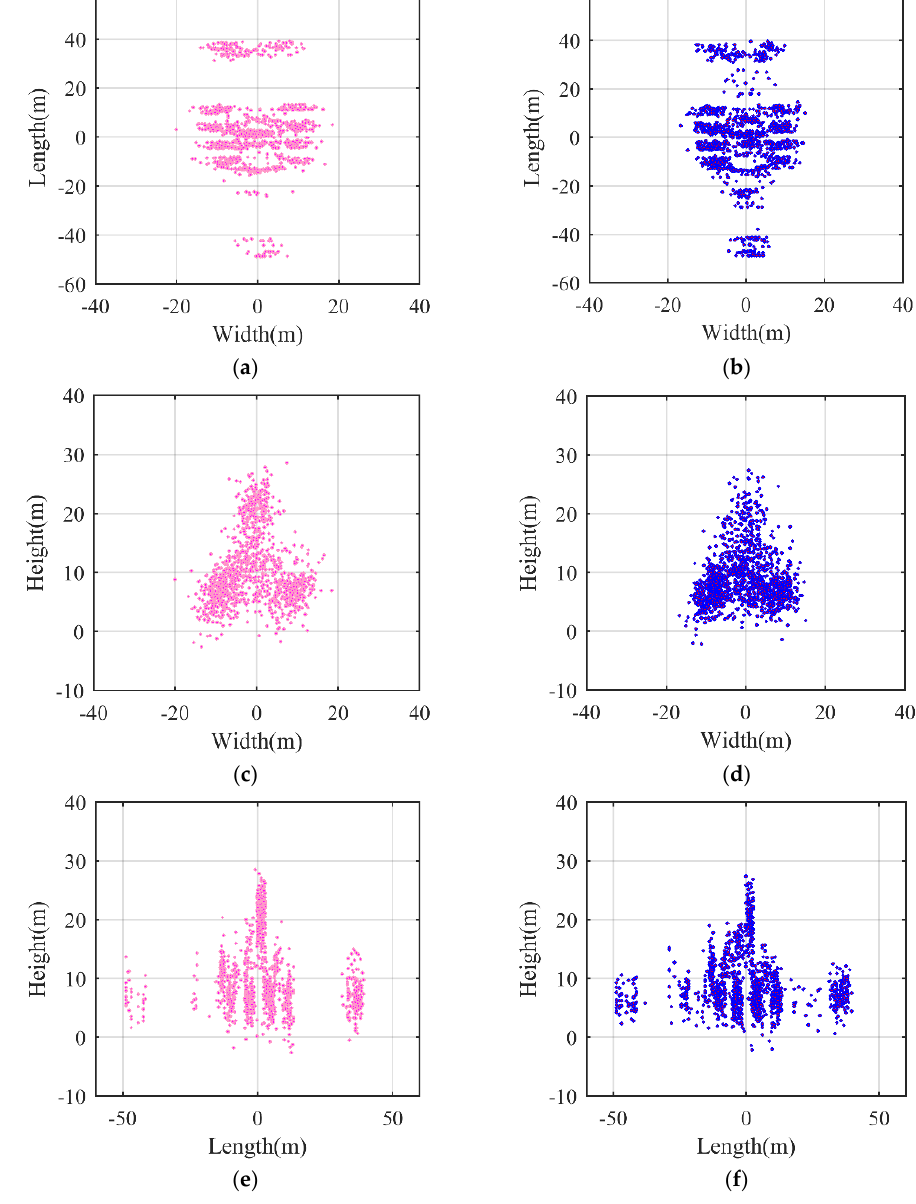
Figure 18. The reconstructed results using the method in [21] and the proposed method. ( a ) Range–horizontal direction view of result using the method in [21]. ( b ) Range–horizontal direction view of proposed method results. ( c ) Range–vertical direction view of result using the method in [21]. ( d ) Range–vertical direction view of proposed method results. ( e ) Vertical–horizontal direction view of result using the method in [21]. ( f ) Vertical–horizontal direction view of proposed method results.